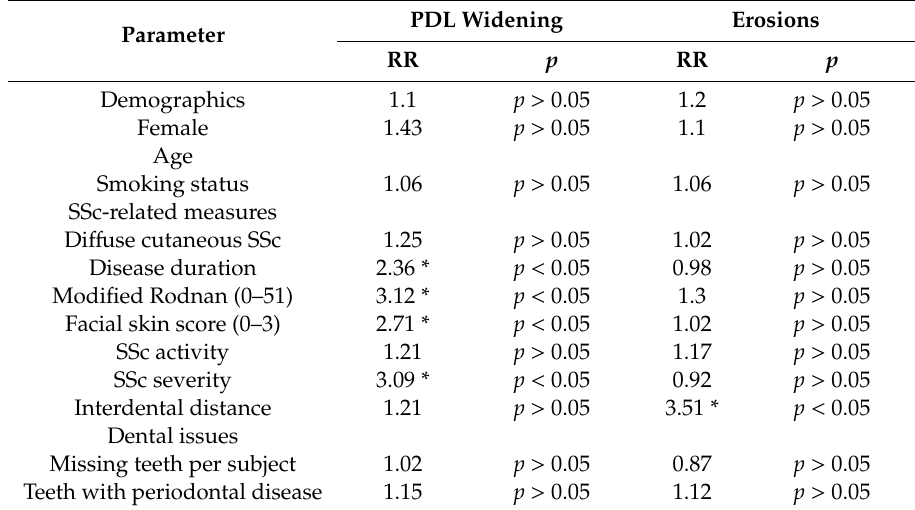
Table 2. Associations between scleroderma-related parameters and oral radiographic abnormalities (univariate analysis). PDL Parameter